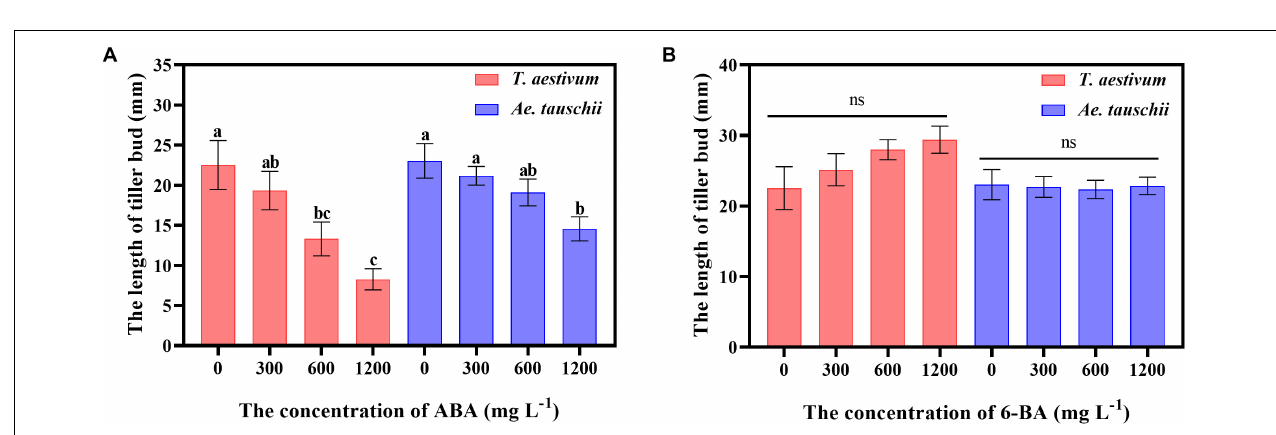
FIGURE 6 | The levels of N6-isopentenyladenosine (A) , trans-zeatin-riboside (B) , total cytokinin (C) , and abscisic acid (D) detected in the 0.5 cm basal part of the stem in T. aestivum and Ae. tauschii at 0, 6, 24, and 72 h after 2,4-D isooctyl ester treatment. Error bars represent the mean ± SD ( n = 3). The significant difference between T. aestivum and Ae. tauschii is indicated ( t -test, * P < 0.05, ** P < 0.01).